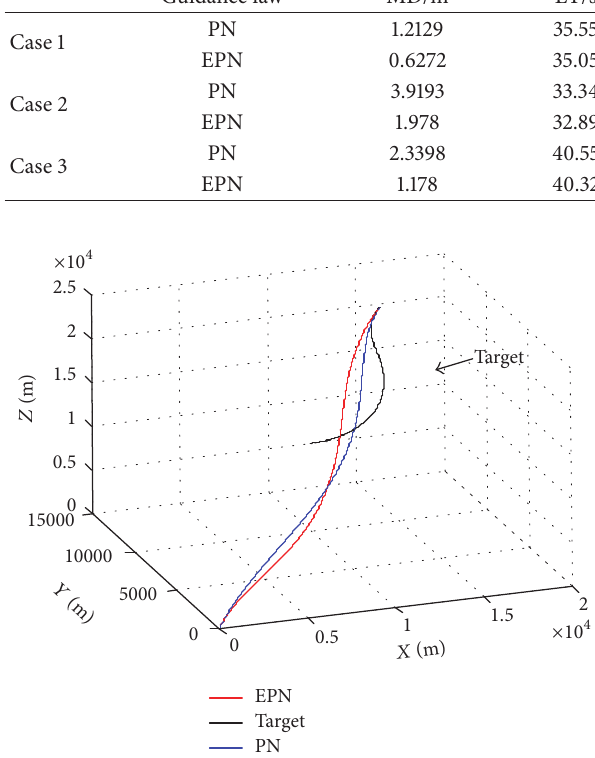
Figure 4: Trajectories of missile and